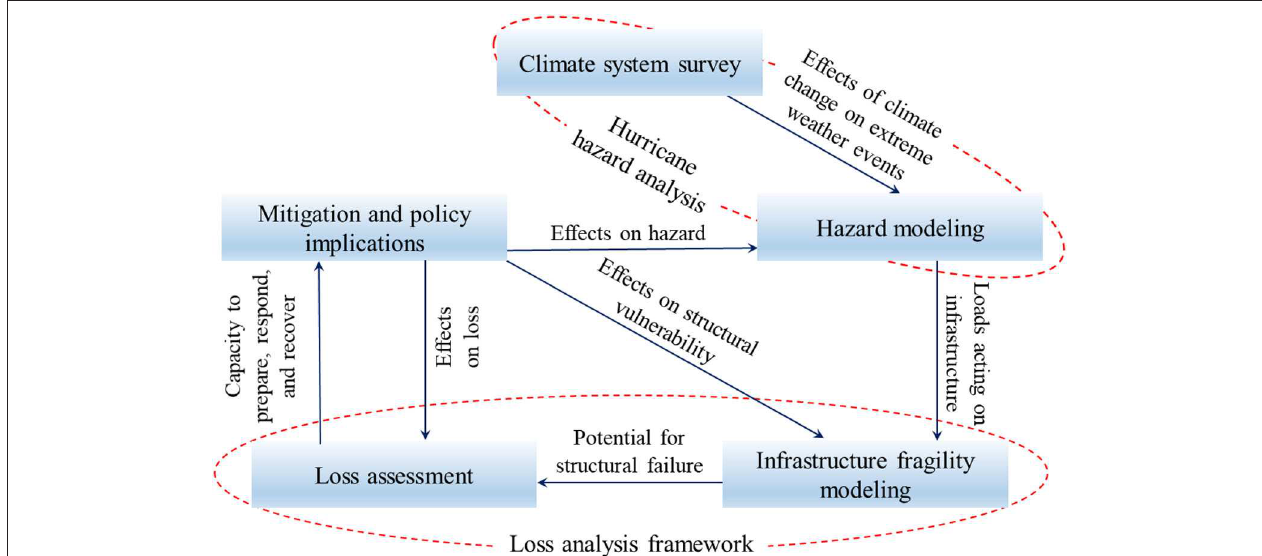
FIGURE 1 | Overview of the integrated risk assessment framework.